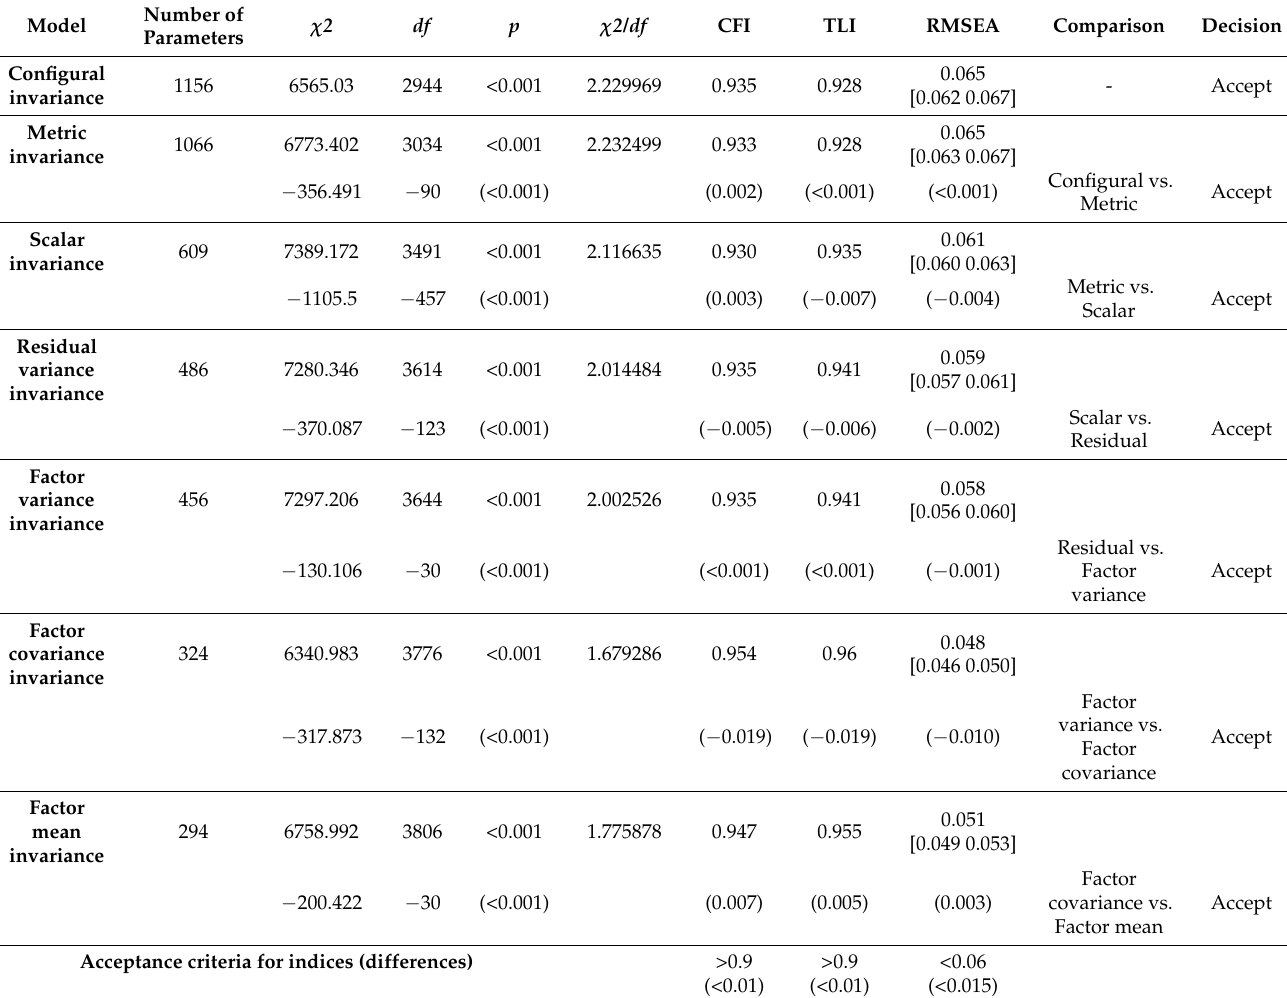
Table 3. MGCFA using fathers’ samples from the USA ( n = 259), South Africa ( n = 318), Nigeria ( n = 328) and India ( n =